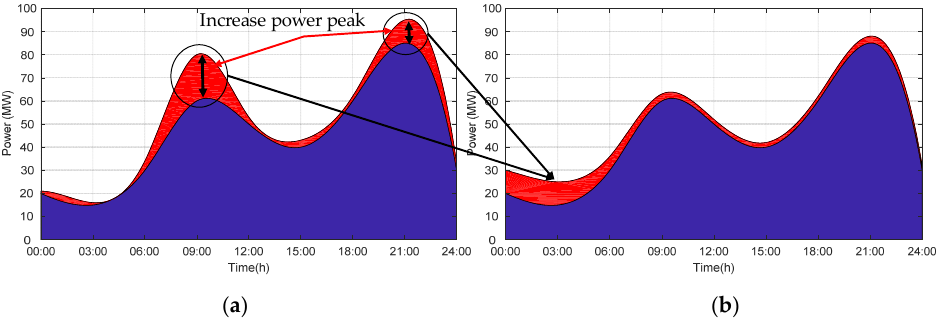
Figure 1. ( a ) Electric vehicles (EVs) charging and peak load; ( b ) Shifted EVs charging to overnight. To overcome this constraint, the EVs can charge with photovoltaic (PV) energy which is a reliable and effective option, to reduce the burden on the public grid [2]. Thus, while the EVs are being charged with green energy [3,4], the EV market will be encouraged since EVs contribute to minimizing the impact of transportation on the environment [3,5,6].